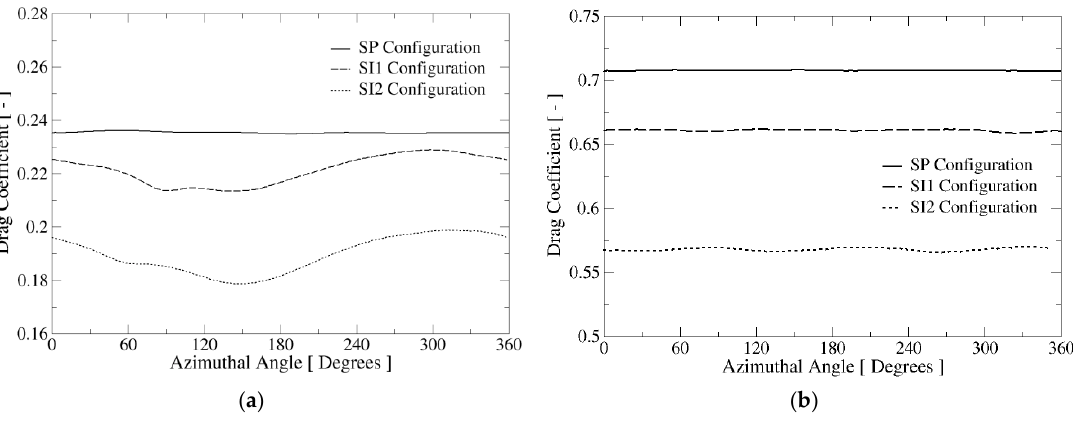
Figure 7. The drag coefficient at λ = 5.7 for the three studied configurations, SP, SI15 (15°), and SI30 (30°) inclined with respect to the flow direction: ( a ) one blade; ( b ) complete turbine.